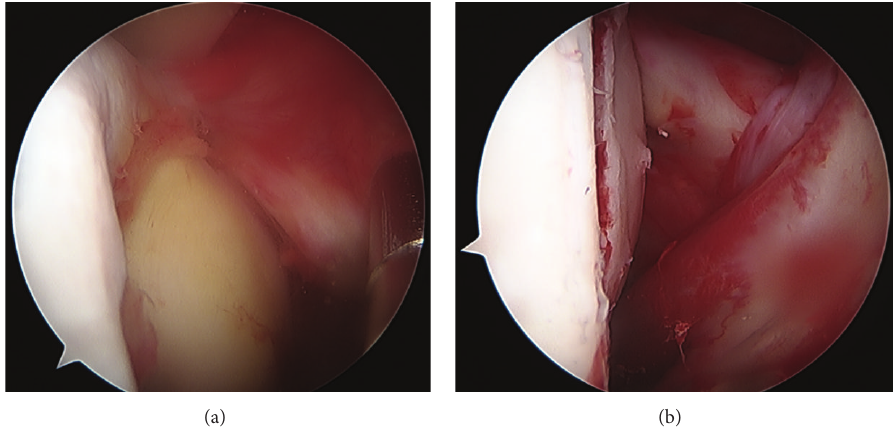
Figure 4: Arthroscopic view (posterolateral portal) of the humeral head before (a) and after (b) reduction of the reversed Hill-Sachs lesion. For internal fixation the subcortical defect was filled with an injectable bone substitute (Cerament).